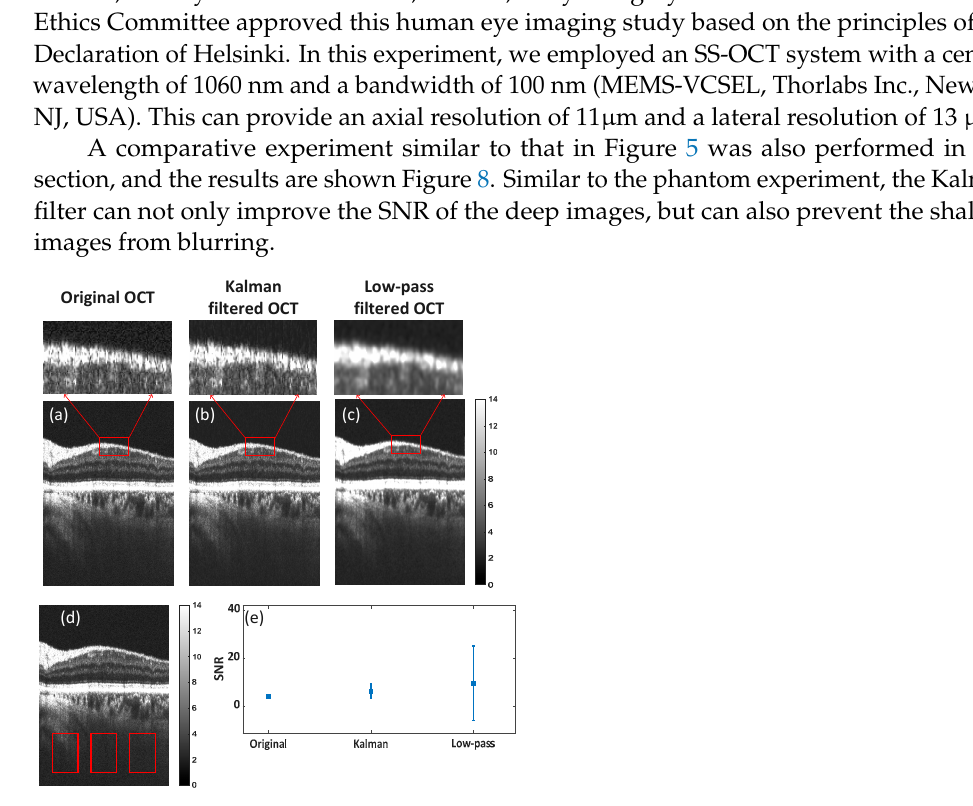
Figure 7. Comparison of OAC obtained using different methods. ( a ) Original OAC image, ( b ) High- error OAC image, ( c ) the OAC image calculated using Li et al.’s algorithm. ( d ) Optimized OAC image. Three rectangular areas are taken out from the shallow, middle and deep positions, respec- tively. ( e – h ) The mean and standard deviation of the OAC in the rectangular regions of the four OAC images.